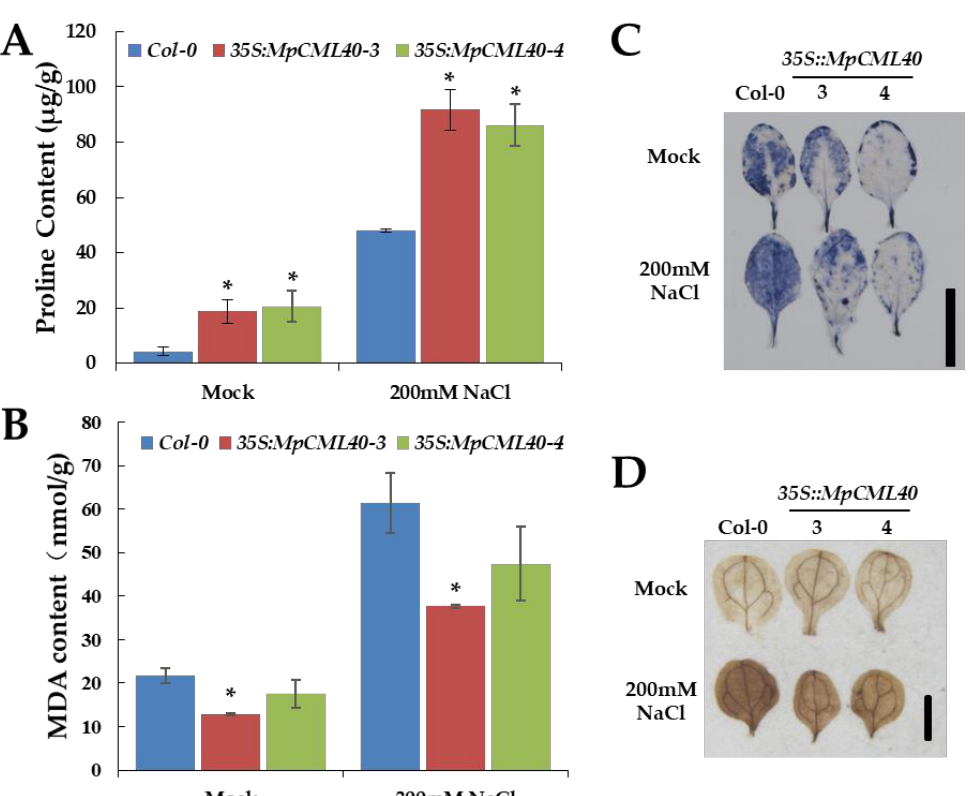
Figure 8. Effects of MpCML40 heterologous expression on salt-stress-related metabolites. ( A ) Proline content of wild-type and 35S::MpCML40 Arabidopsis plants. ( B ) Micro Malondialdehyde (MDA) content of wild-type and 35S::MpCML40 plants. Error bars show mean values (±SD) of germination rate from three independent samples. * p < 0.05 (Student’s t -test). ( C ) NBT staining of wild-type and 35S::MpCML40 four-week-old Arabidopsis rosette leaves. Bar = 1 cm. ( D ) DAB staining of wild-type and 35S::MpCML40 two-week-old Arabidopsis cotyledons grown on ½ MS agar plates. Bar = 1 mm.